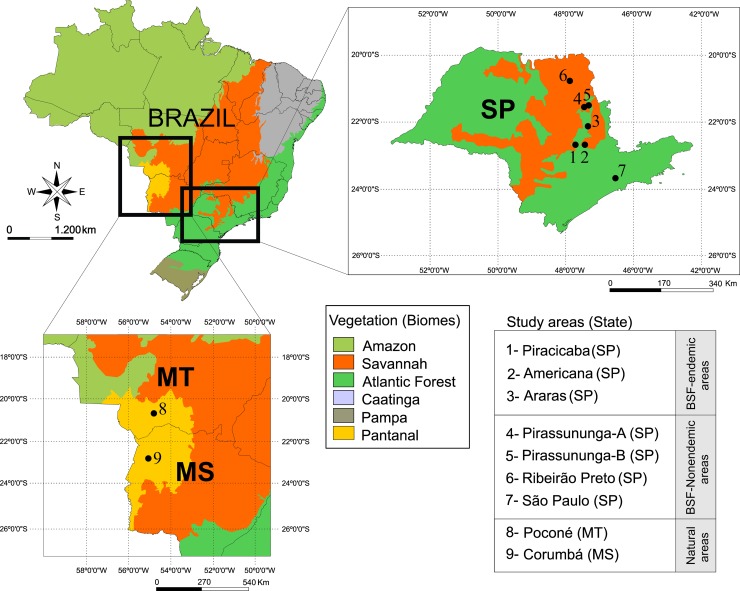
Areas where capybaras and ticks were sampled in the state of São Paulo (SP) (highly anthropic, low diversity areas), and in the states of Mato Grosso (MT) and Mato Grosso do Sul (MS) (low anthropic, high diversity areas).Map source was obtained from the “Instituto Brasileiro de Geografia e Estatística”(IBGE) website (www.ibge.gov.br) and the final figure was constructed with the use of CorelDraw Graphics Suite 2017.